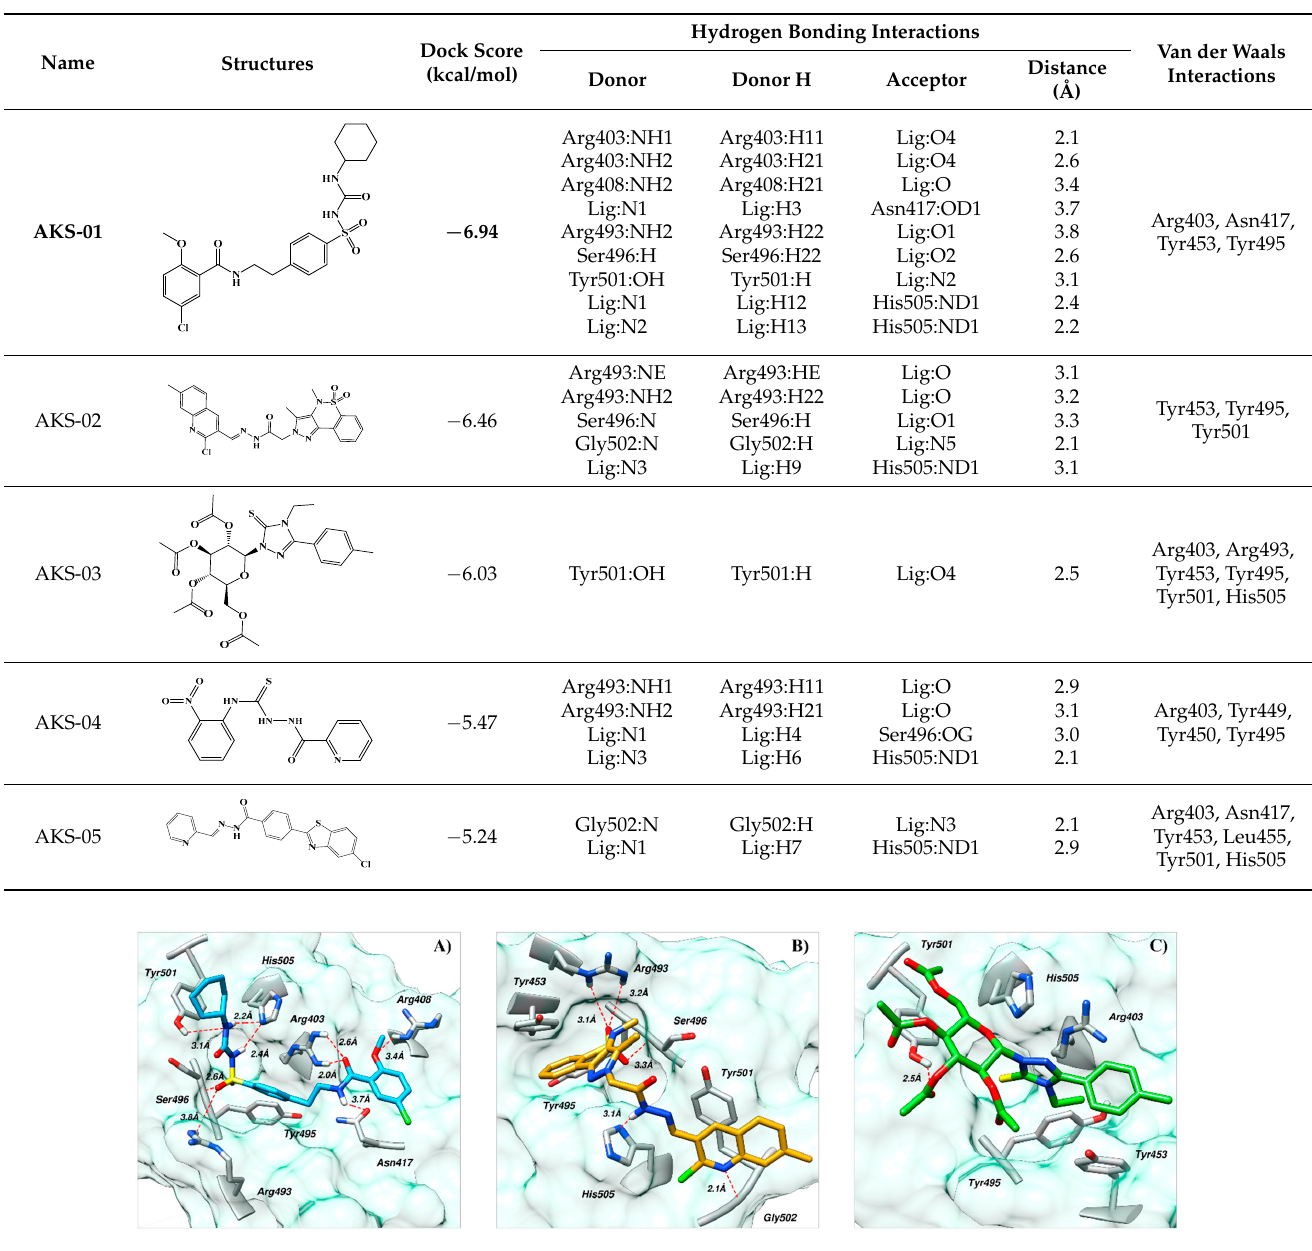
Table 1. Two-dimensional structures, docking scores and comprehensive interactions between RBD of Spike protein and the selected hit compounds.